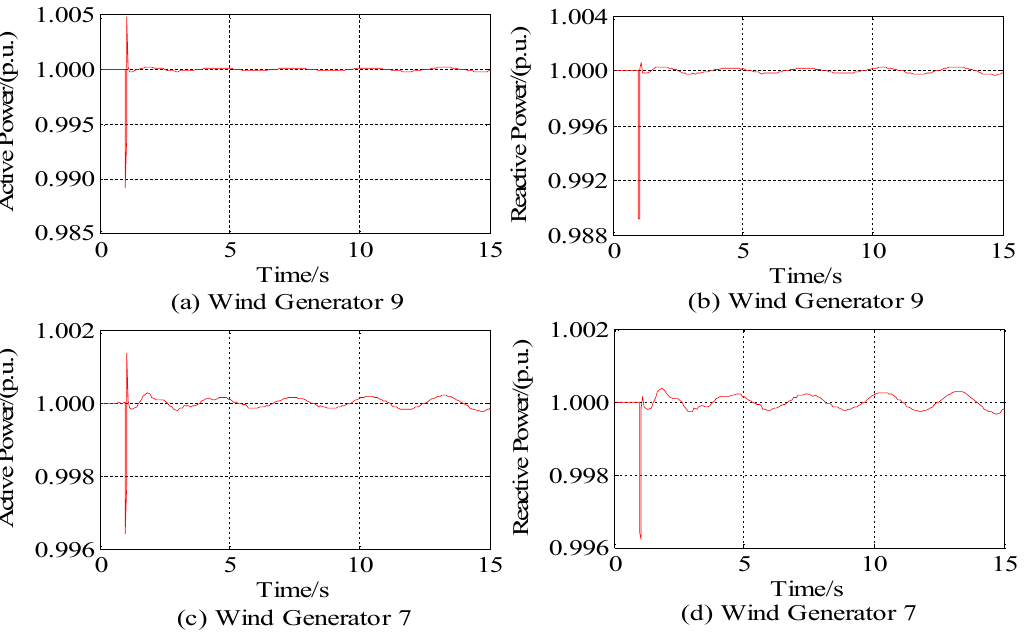
Figure 6. Power oscillation of WTGs G9 and G7 under the penetration level of 50.17%. ( a ) the active power curves of the WTGs G9; ( b ) the reactive power curves of the WTGs G9; ( c ) the active power curves of the WTGs G7; ( d ) the reactive power curves of the WTGs G7.